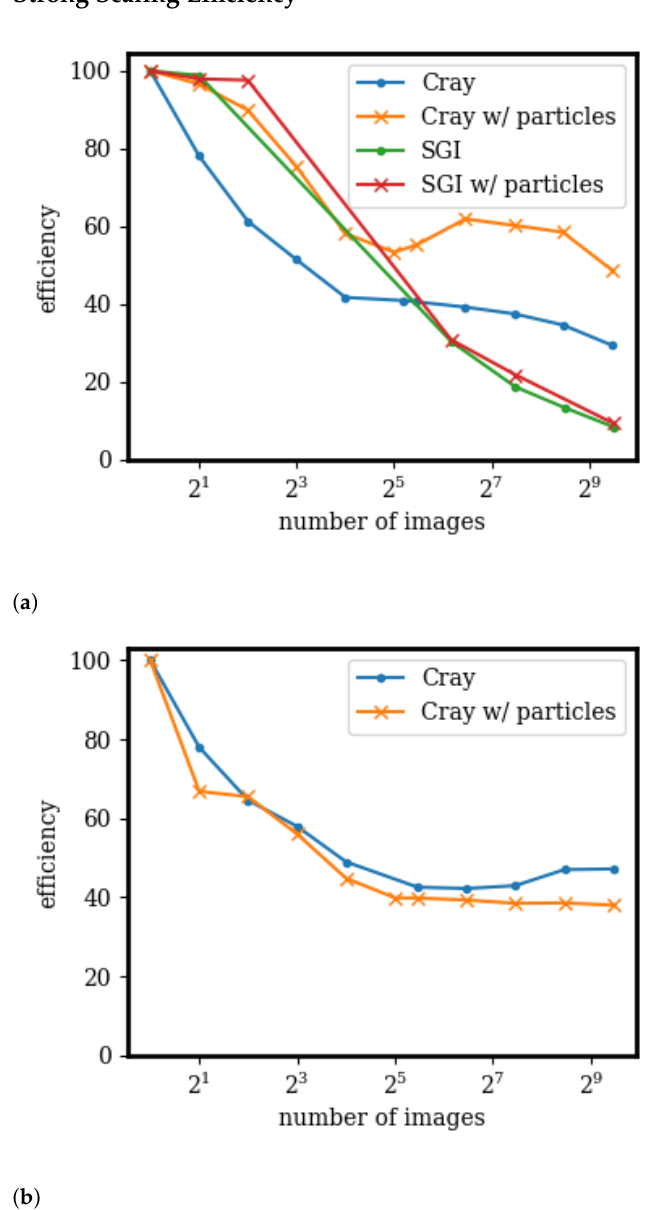
Figure 15. ( a ) Grid dimensions 500 × 500 × 30. ( b ) Grid dimensions 2000 × 2000 ×